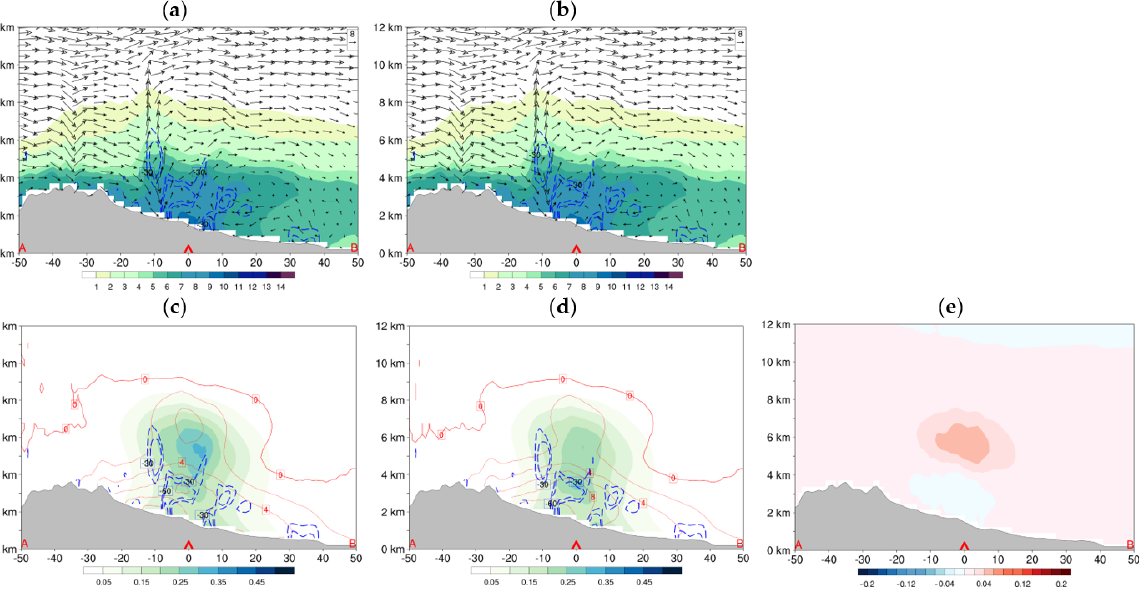
Figure 8. Vertical cross-section of the analysis and the increment of water vapor (unit g/kg) along line AB at 0800 UTC. ( a ) The analysis from C2Rad. ( b ) The analysis from C2RadBy. ( c ) The increment from C2Rad. ( d ) The increment from C2RadBy. ( e ) The difference of increment between C2Rad and C2RadBy. The shades in each plot indicate the water vapor mixing ratio (unit g/kg). The solid red lines indicate the increment of temperature (unit 0.001 °C). The dashed blue lines indicate negative divergence (unit 1/s).